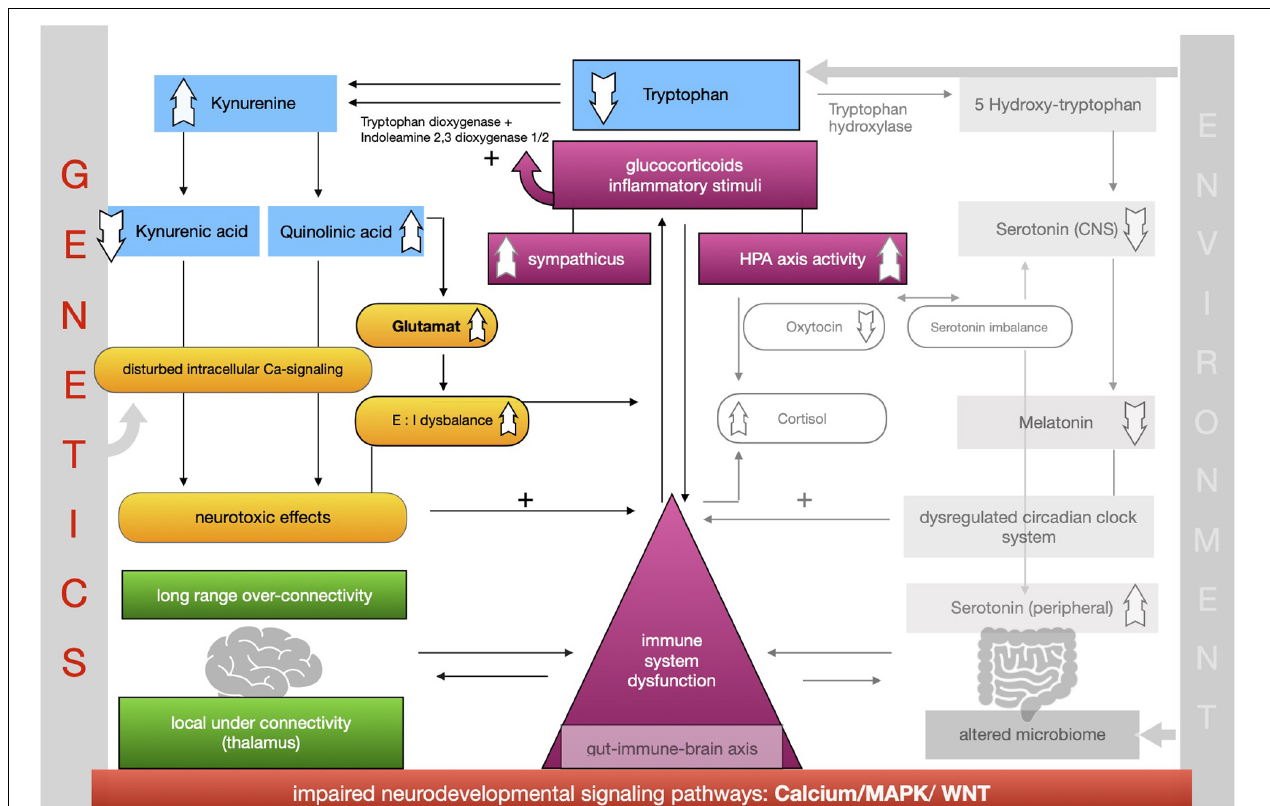
FIGURE 2 | Feedback circuit